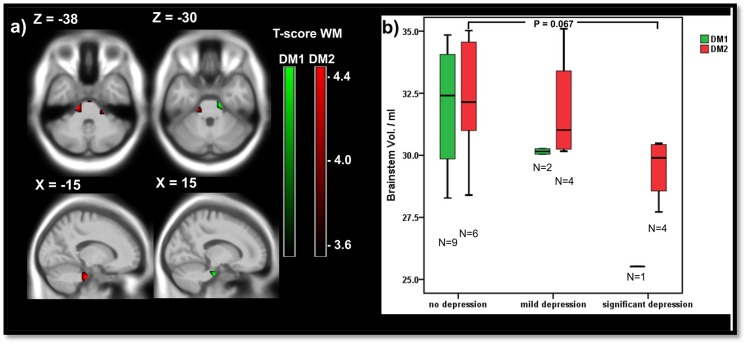
Depression and brainstem volume.a) Negative correlations between white matter and the depression grade in 12 DM1 (green) and 15 DM2 (red) patients: voxelwise multiple regression with the depression score (BDI-II) as covariate; areas with uncorrected p<0.001 at peak level are shown; X,Y,Z: MNI-coordinates: negative X-values reflect left side and positive X-values right sided location. b) Brainstem volume of DM1 and DM2 patients in dependency of the depression grade: no depression: score < = 11; mild depression: score 12–19; significant depression: score > 20; significance of group differences by Mann-Whitney-U tests.